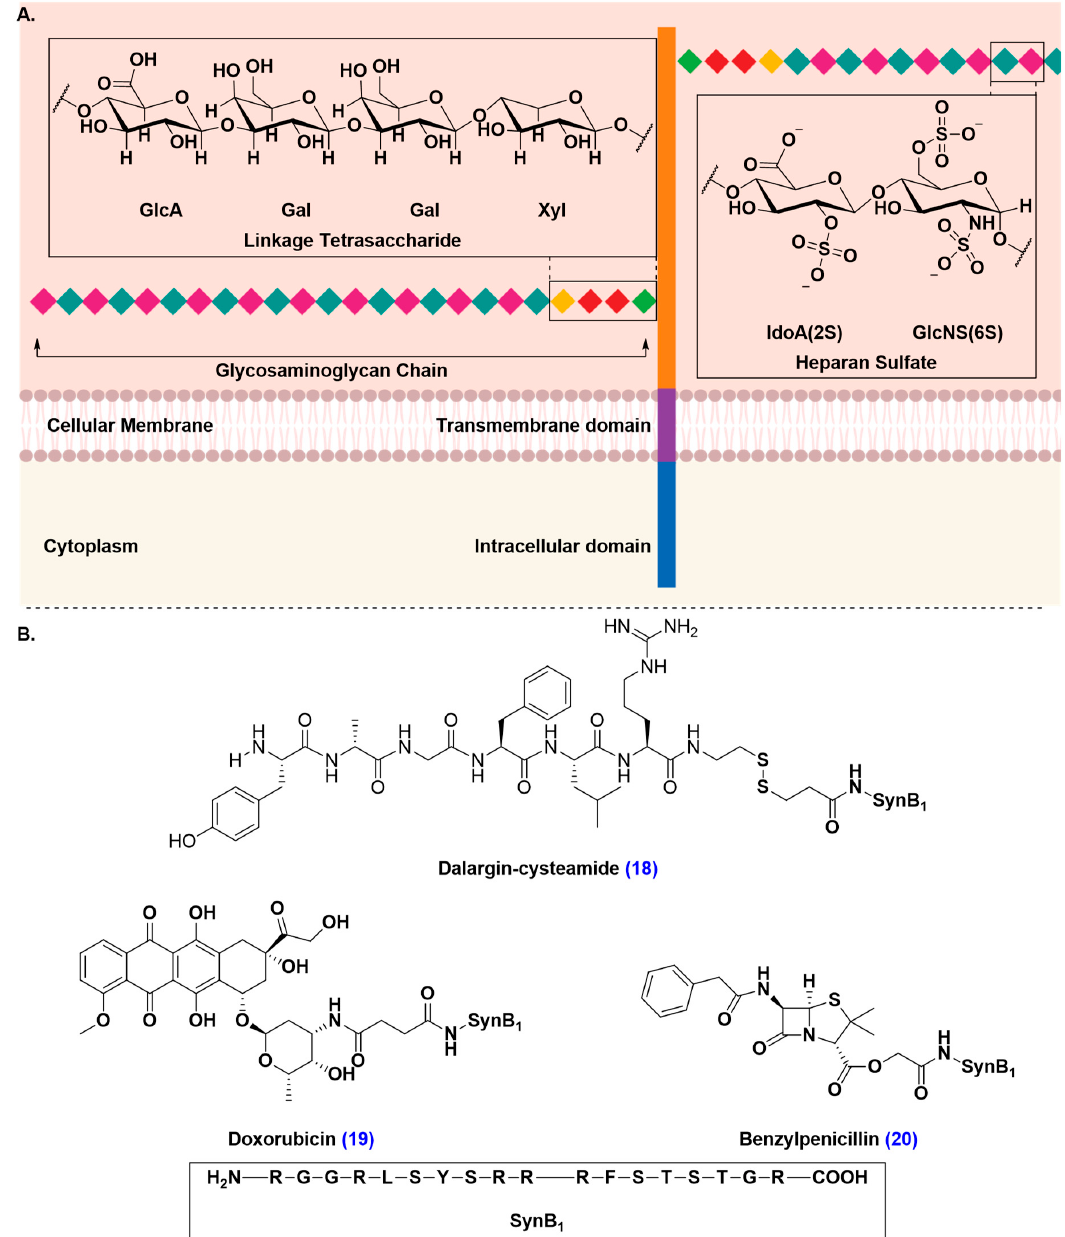
Figure 19. Delivery of therapeutics to the brain by exploiting adsorptive-mediated transcytosis (AMT) of the delivery vectors with anionic proteoglycans, such as syndecan-4. ( A ) Structure of syndecan-4. Syndecan-4 is a proteoglycan that is a heavily glycosylated transmembrane protein. The protein consists of an extracellular domain that carry one or more covalently attached glycosaminoglycan (GAG) chain(s). GAG chains are long, linear carbohydrate polymers that are negatively charged under physiological conditions due to the presence of sulfate and uronic acid groups. The GAG chain allows for the interaction with a large variety of ligands, such as growth factors and enzymes. GAG chains are attached to the extracellular domain through a tetra-saccharide bridge (GlcA-Gal-Gal-Xyl). ( B ) Structure of SynB 1 drug conjugates of cysteamide-modified dalargin, an analgesic drug, doxorubicin, a chemotherapeutic agent, and benzylpenicillin, an antibiotic that exploits AMT to trigger brain uptake of its therapeutic cargo.